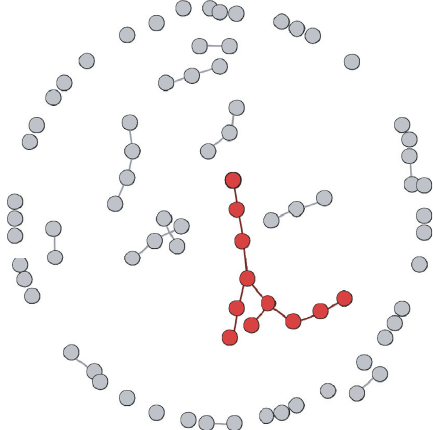
Figure 2: Initial state of alliance